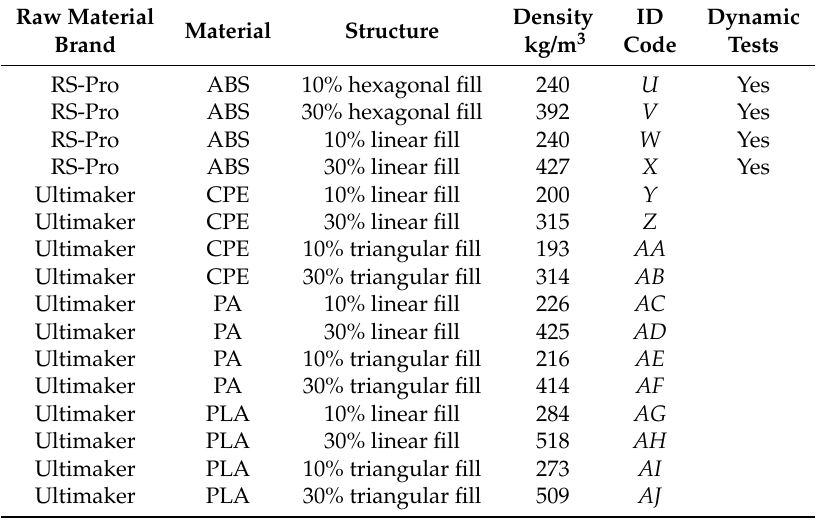
Table 2. Physical properties of the investigated materials: 3D printed.